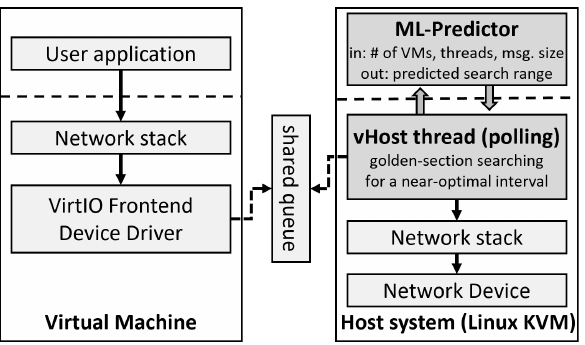
Figure 1. Architecture of